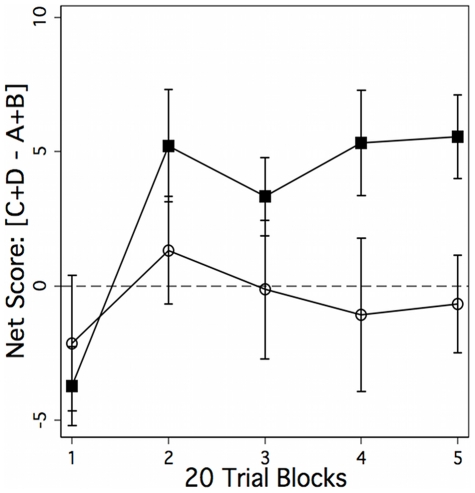
Decision making performance on the Iowa Gambling Task (IGT) for the cocaine- dependent (open circle) and control (black square) subjects.Described in detail in the experimental procedures, each trial on the IGT presents subjects with four choices represented as decks of cards. Two sets (decks C, D) return a positive net gain, and two (A, B) return a net loss. The figure shows the net score (choice of advantageous decks - disadvantageous decks) across 100 test trials, divided into five 20-trial blocks. Beginning between trial 20 and 40, control subjects shifted preference toward decks C and D (net gain), while cocaine dependent subjects continued to divide choices evenly between advantageous and disadvantageous decks, slightly favoring decks A and B (net loss). This between-group difference was statistically significant: F (1, 31)  = 4.32, p = .046.